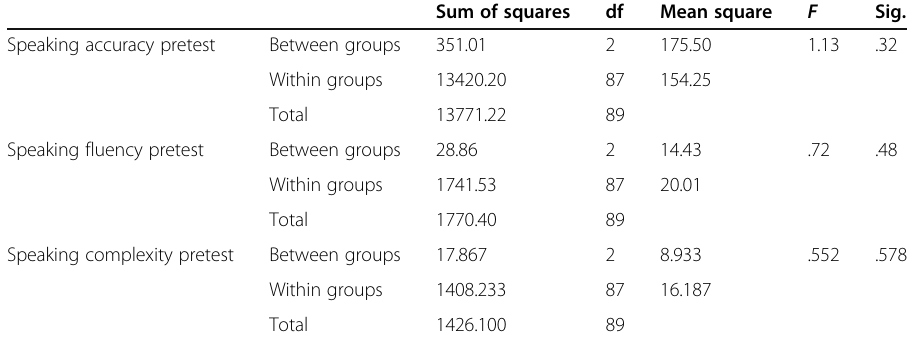
Table 2 Results of one-way ANOVA for comparing GDA, C-DA, and NDA mean scores on the pretest